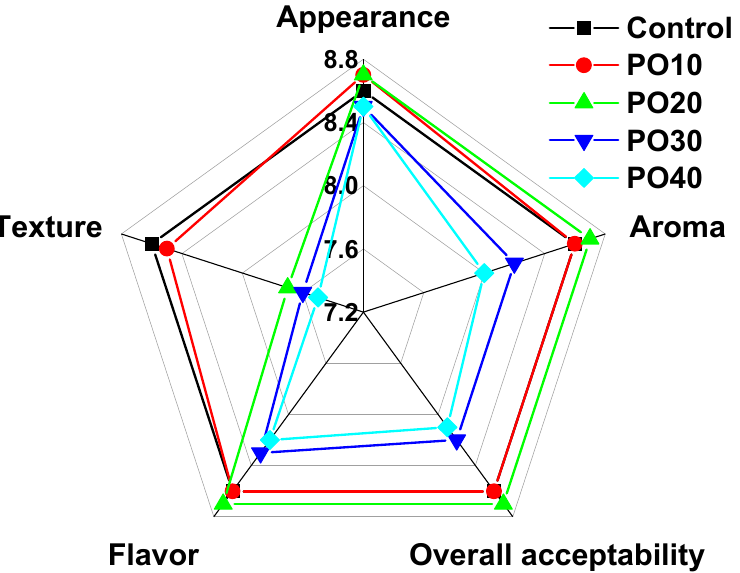
Figure 1. Sensory evaluations of each group of sausages.